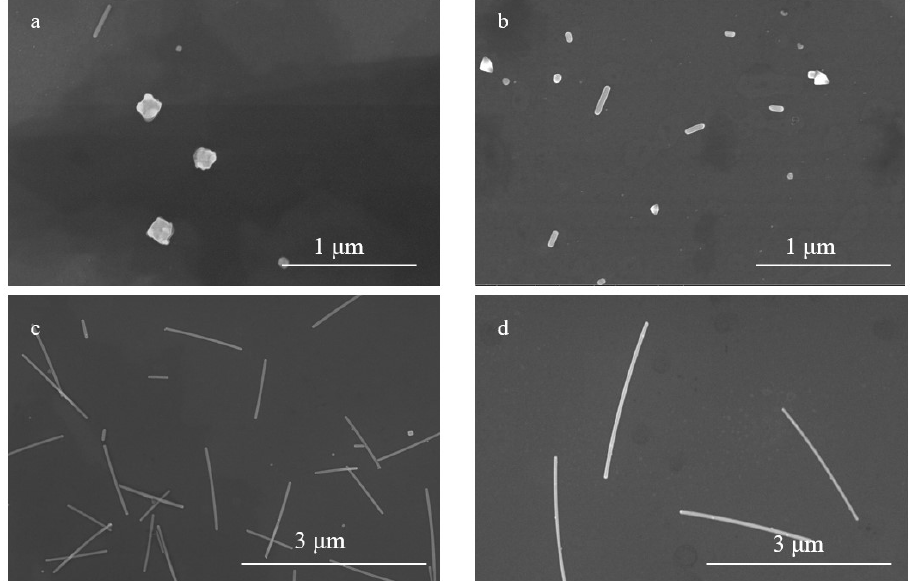
Figure 6. SEM images of AgNWs at 160 °C with NaCl as crystal seed additive at ( a ) 12 min, ( b ) 14 min, ( c ) 16 min, and ( d ) 18 min.